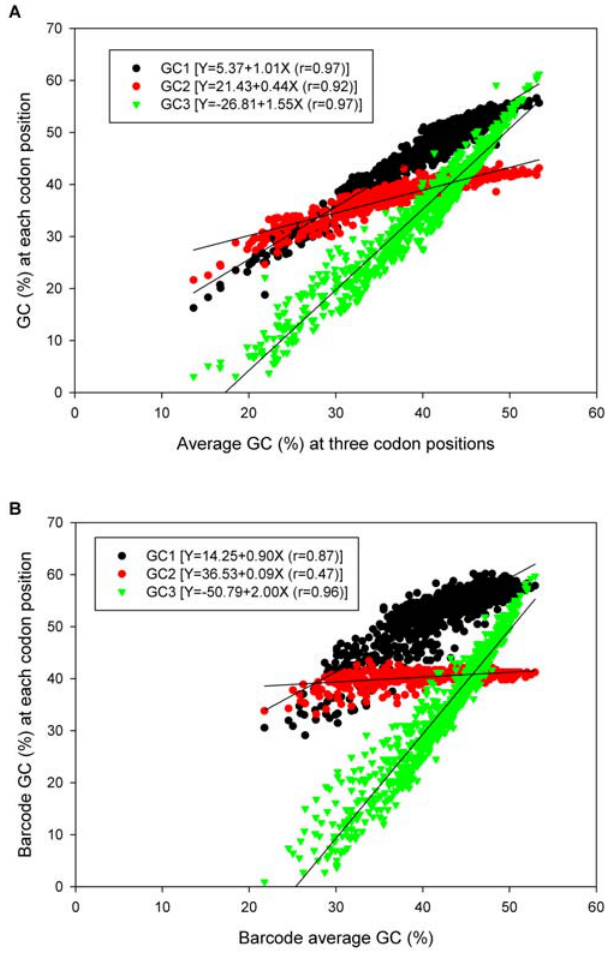
Figure 2. Correlation between GC content at each codon position and the average GC content. Panel A shows the results for all protein coding sequences in the mitochondrial genome. Panel B shows the results based on the DNA barcode region alone.